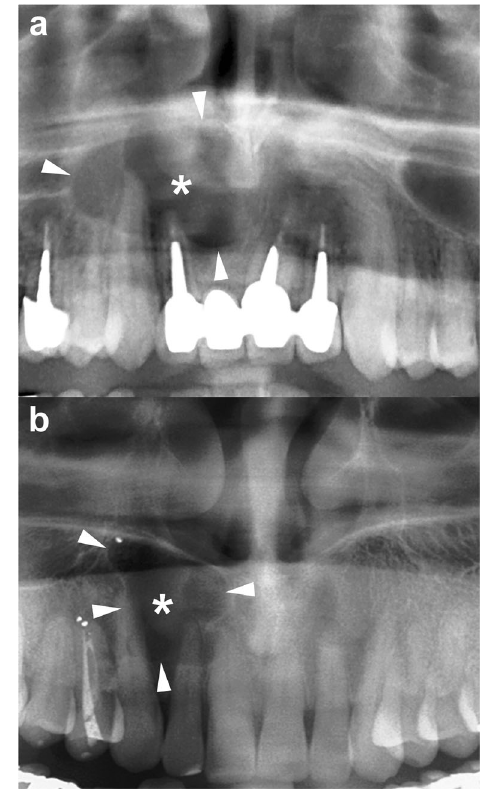
Fig. 3 Histologically proven OKCs. Cropped panoramic radiographs ( a and b ) show two unilocular radiolucent lesions ( asterisks ) with well- defined and corticated margins ( arrowheads ) located in the anterior maxilla, between the roots of the adjacent teeth. The radiographic aspect of these radiolucent lesions may simulate a radicular